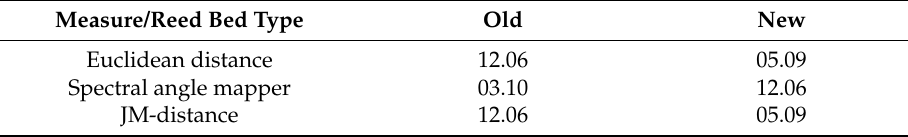
Table 6. The optimal date to separate reed beds from other vegetation.